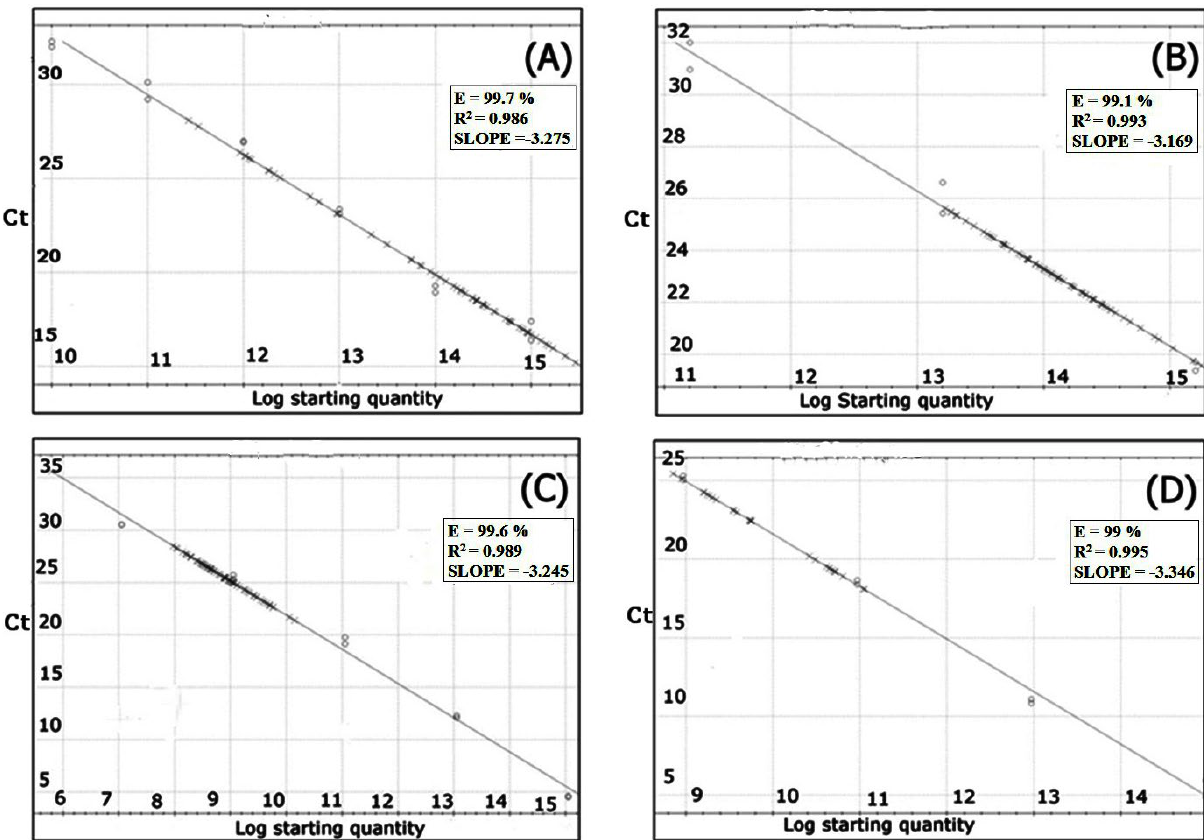
Figure 3. Standard curves obtained from Apple mosaic virus , Apple stem grooving virus , Apple stem pitting virus and Apple chlo- rotic leaf spot virus amplification analyzed using linear regression, plotting the threshold cycle values ( C t) vs. the logarithm of the actual starting RNA copy number. (A): ApMV; (B): ASGV; (C): ASPV and (D): ACLSV. (O): standard; (X): unknown; (-):